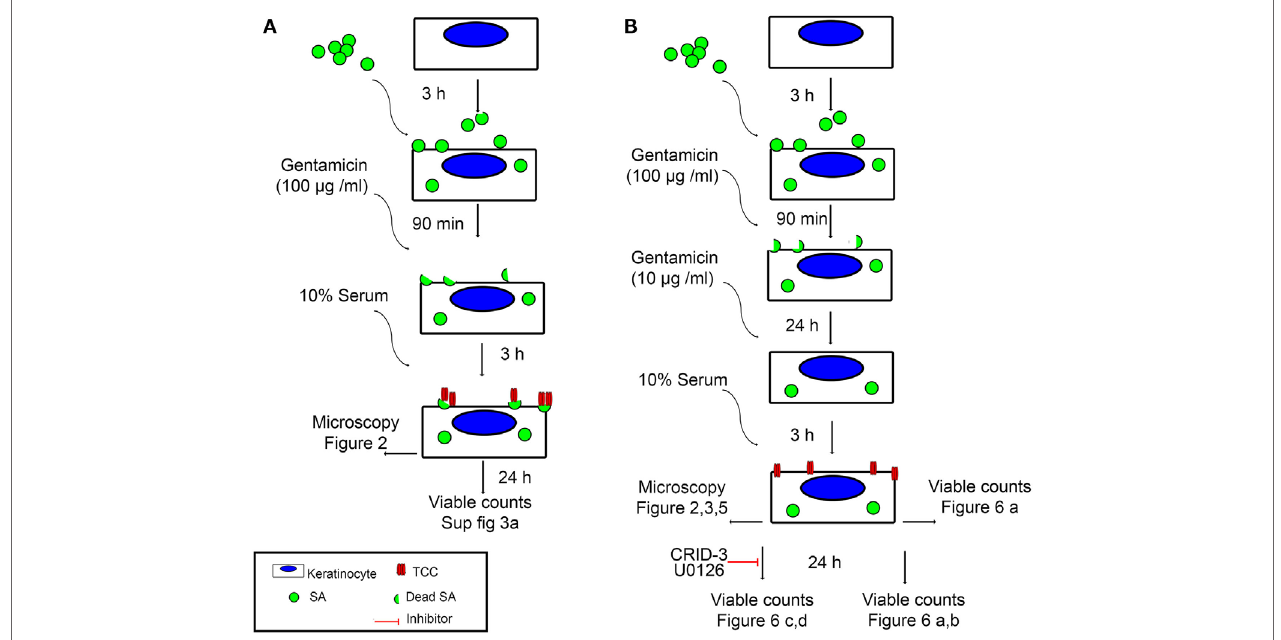
FigUre 1 | Experimental setup. An illustration of the two infection models used in this study, as well as the figures corresponding to the time points and analysis methods used. (a) Keratinocyte monolayers are infected with Staphylococcus aureus (SA) for 3 h, followed by killing of extracellular bacteria using 100 µg/ml Gentamicin for 90 min. At this time point, intracellular SA is referred to in the text as intracellular SA present immediately after infection . Incubation with normal human serum (NHS) at this time point leads to deposition of terminal complement complex (TCC) mostly on extracellular bacterial remnants. (B) Keratinocyte monolayers are infected with SA for 3 h, followed by killing of extracellular bacteria using 100 µg/ml Gentamicin for 90 min, keratinocytes are further incubated with 10 µg/ml Gentamicin for 24 h, at this time point, intracellular SA is referred to in the text as persistent intracellular SA. Incubation with NHS at this time point leads to deposition of TCC on the surface of